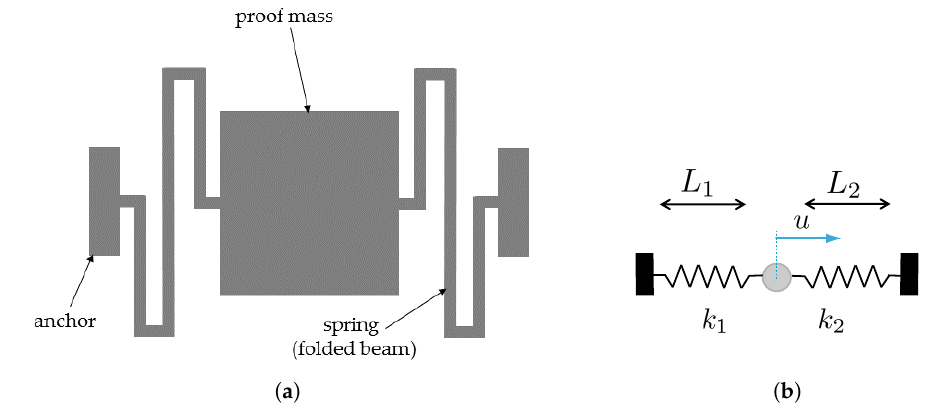
Figure 1. ( a ) Example and ( b ) structural scheme of single-axis inertial MEMS devices, featuring a proof mass anchored to the die via two springs in